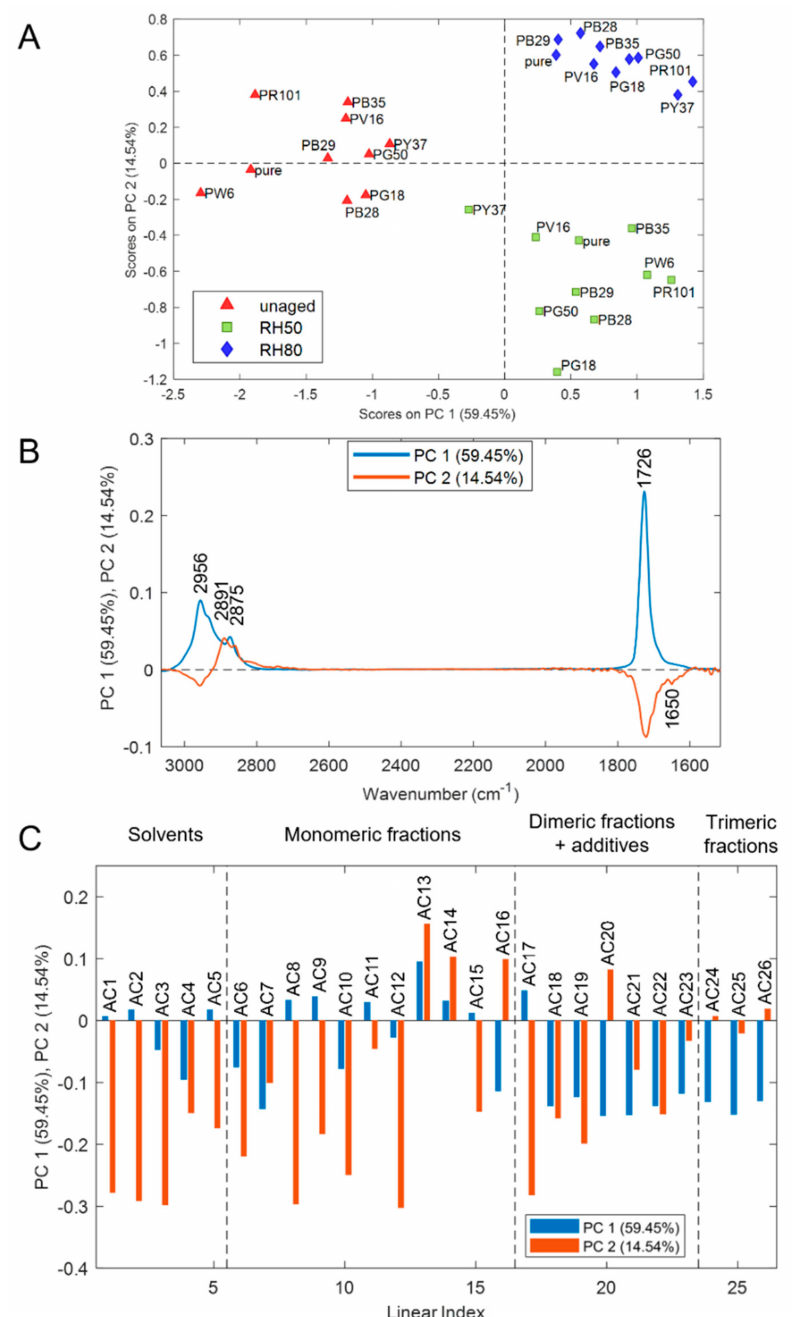
Figure 7. Results of PCA model calculated on FT − , R and Py − , GC/MS fused dataset of acrylic samples: ( A ) PC1 and PC2 score plot, ( B ) PC1 and PC2 loadings of FT-IR variables, and ( C ) PC1 and PC2 loadings of Py-GC/MS